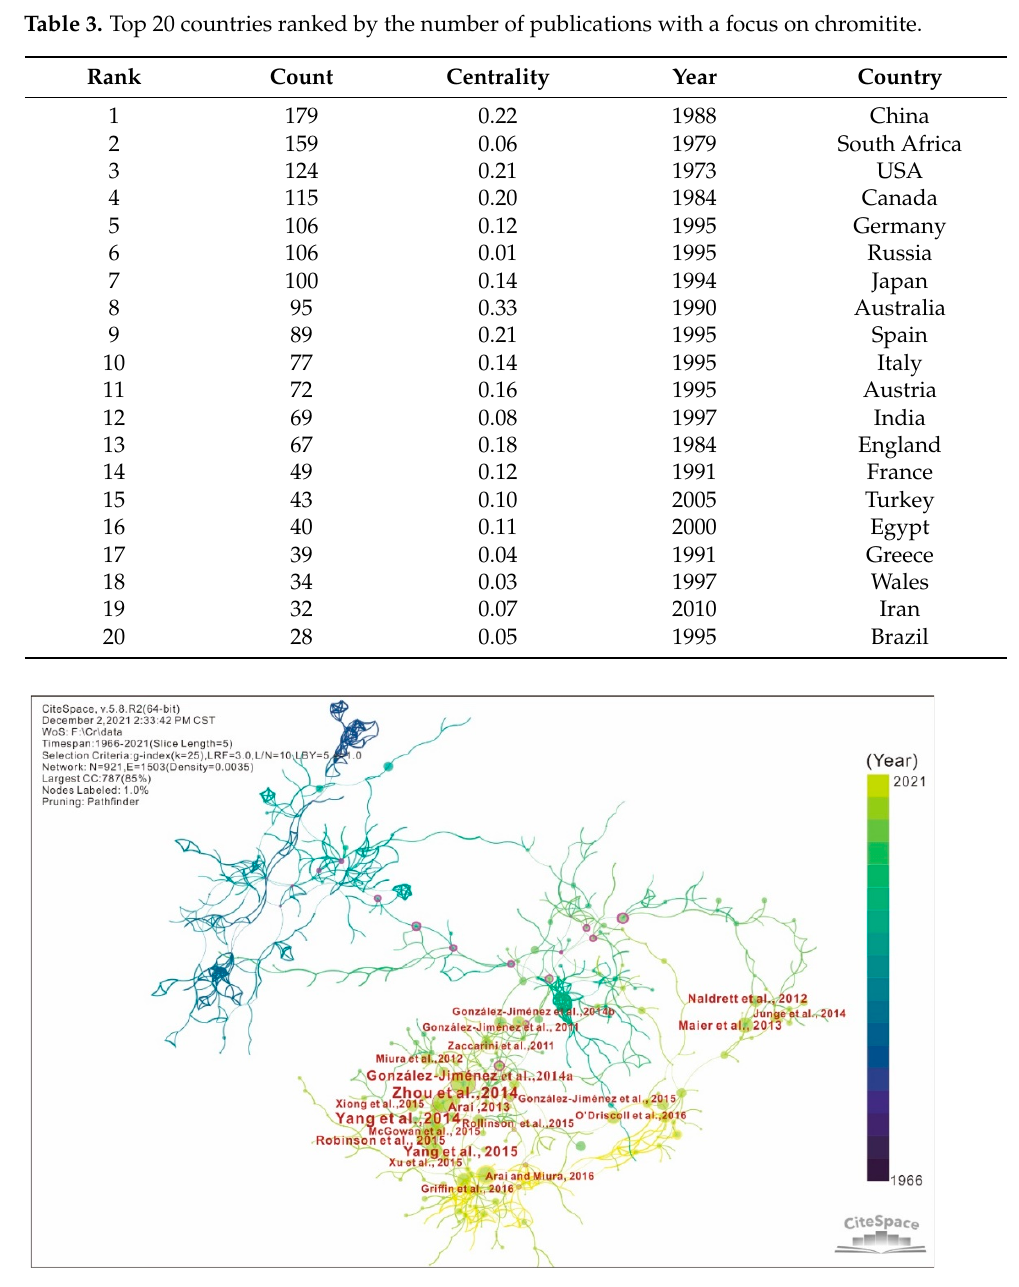
Figure 5. Co-occurring references map. Table 4. Top 20 co-citation references related to chromitite.